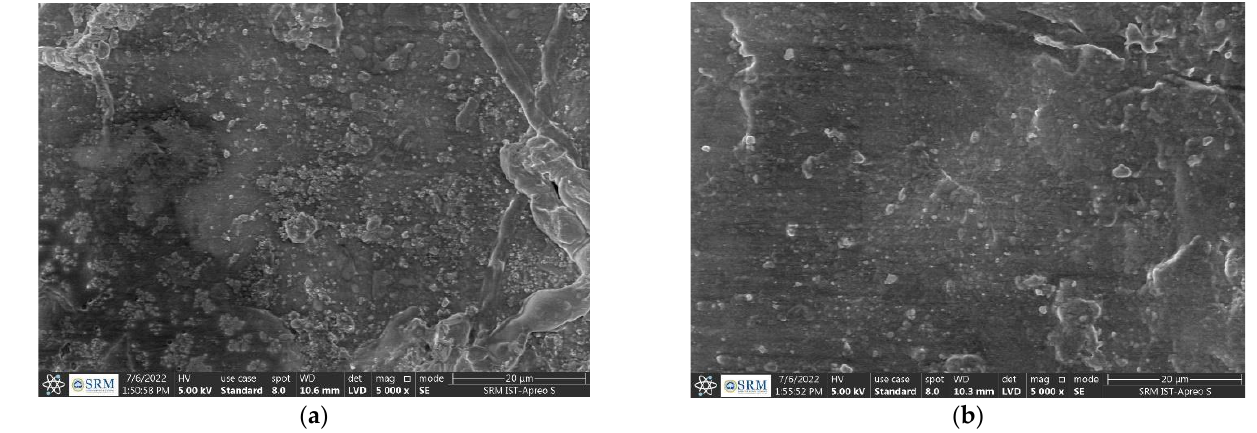
Figure 6. SEM micrographs of coir fiber-reinforced P-PVC. ( a ) 6 wt.% of fiber + 150 μm + triethoxy (ethyl) silane ( b ) 2 wt.% of fiber + 75 μm+ NaOH .